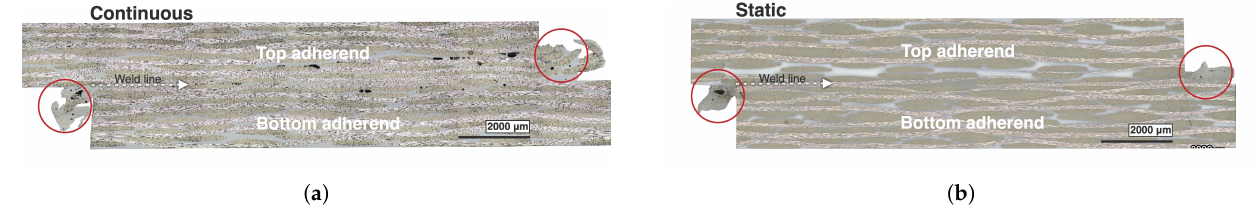
Figure 2. Cross-sectional micrographs of a ( a ) continuous (adapted from [15]) and a ( b ) static ultrasonic weld. Welding force 500 N, vibration amplitude 80 µ m, welding speed 35 mm/s ( a ), equivalent vibration time 430 ms ( b ) [14]. The same clamping jig and clamping configuration is used in both cases. The red circles indicate squeeze out of fibres and/or